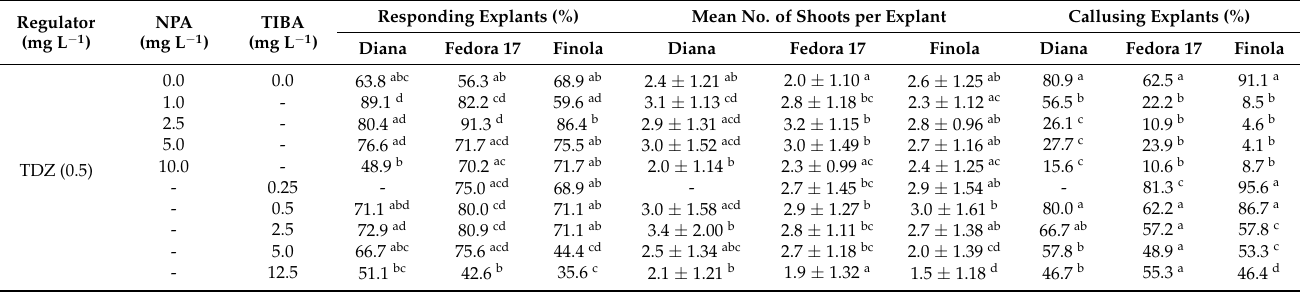
Table 3. Effect of auxin transport inhibitors NPA and TIBA and genotype on shoot regeneration of C. sativa epicotyl explants cultured after three weeks of culture on medium with TDZ.